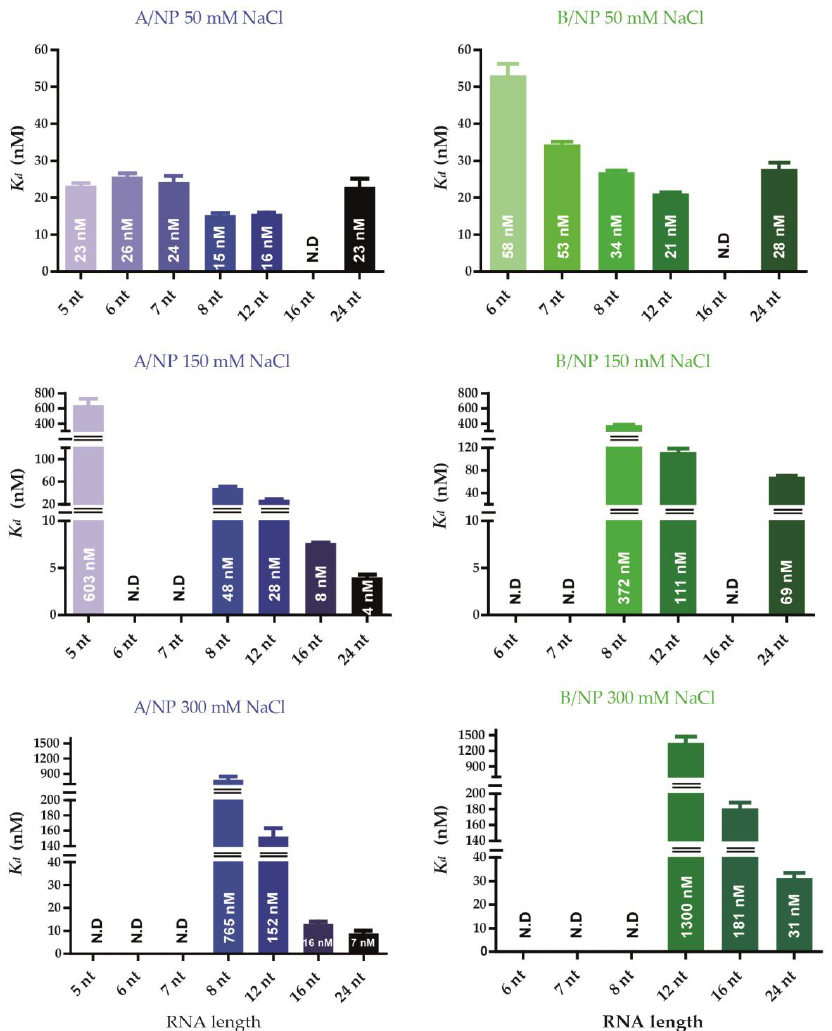
Figure 6. Affinities of both nucleoproteins of influenza A and B viruses for different RNAs. All the fluorescence anisotropy experiments were performed in triplicate in 20 mM Tris-HCl pH 7.5, 5 mM β -ME, and different NaCl concentrations (from 50 to 300 mM). The titration of NP was done against 5 (cid:48) phosphate-polyUC-FAM 3 (cid:48) RNAs ranging from 5 to 24 nt. The mixes were incubated 5 min at room temperature. Curves are shown in Figure S4. N.D: